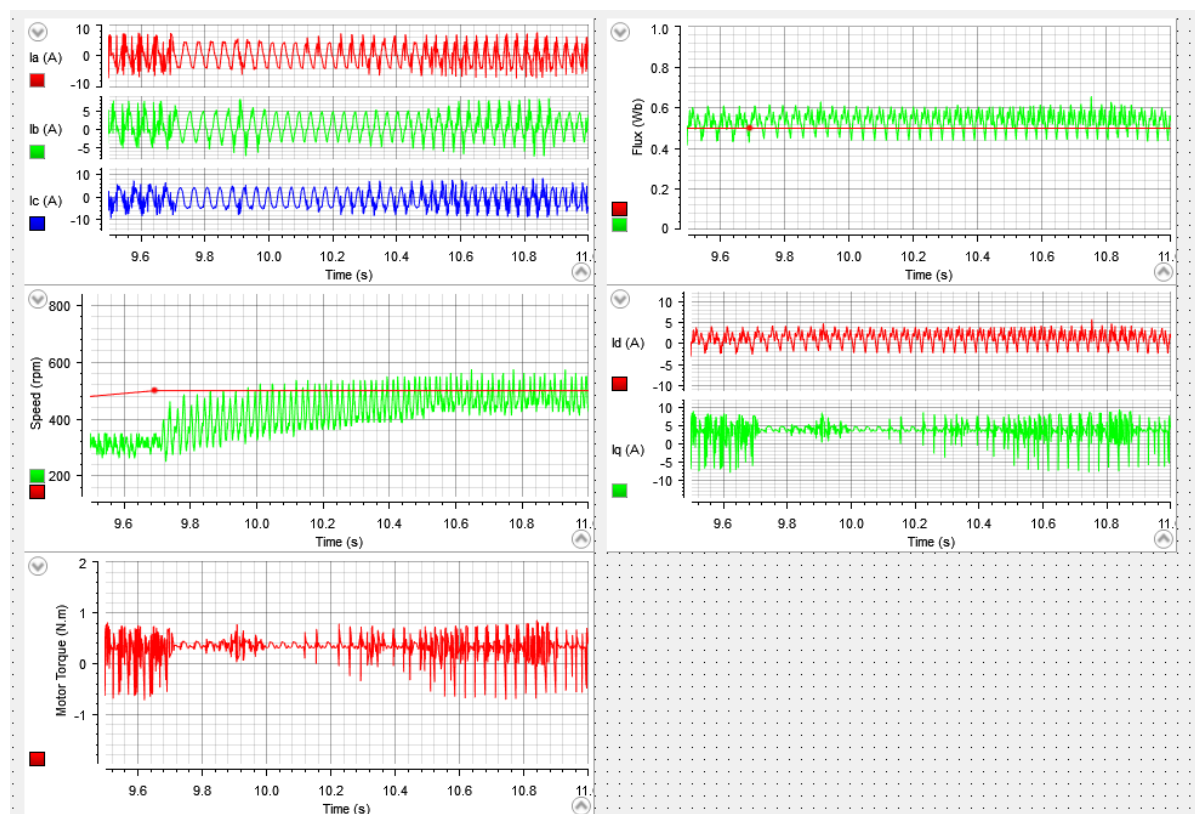
Figure 10. The transient PMSM performance at speed